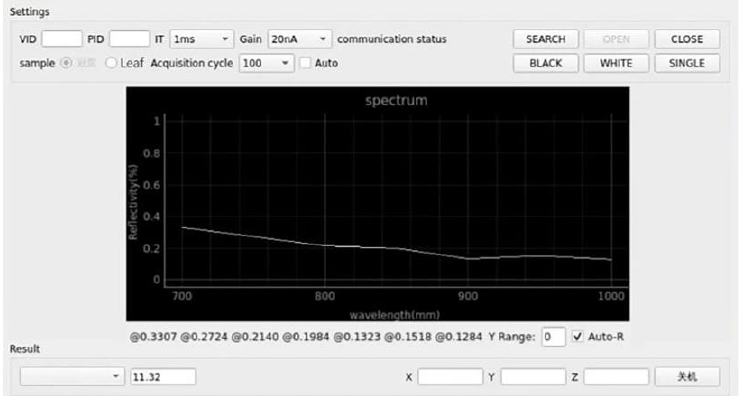
Figure 4. Visual interactive interface.